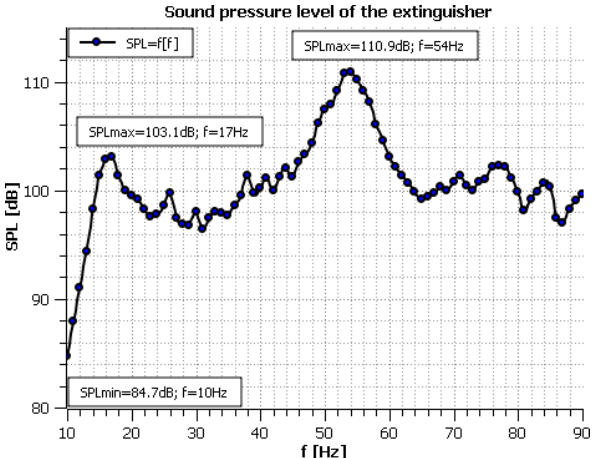
Figure 4: Sound pressure level curve of the extinguisher